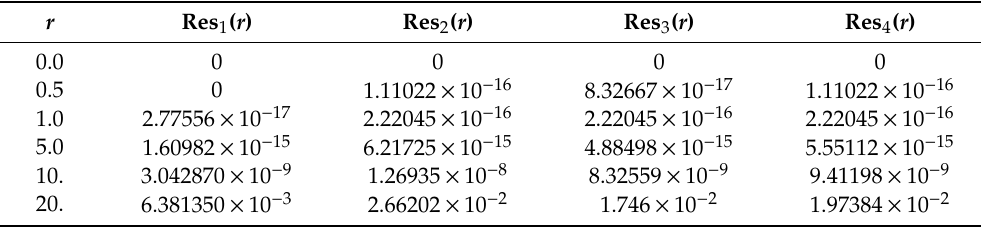
Table 17. The value of the 10th-residual error ( Res 10 classical method.